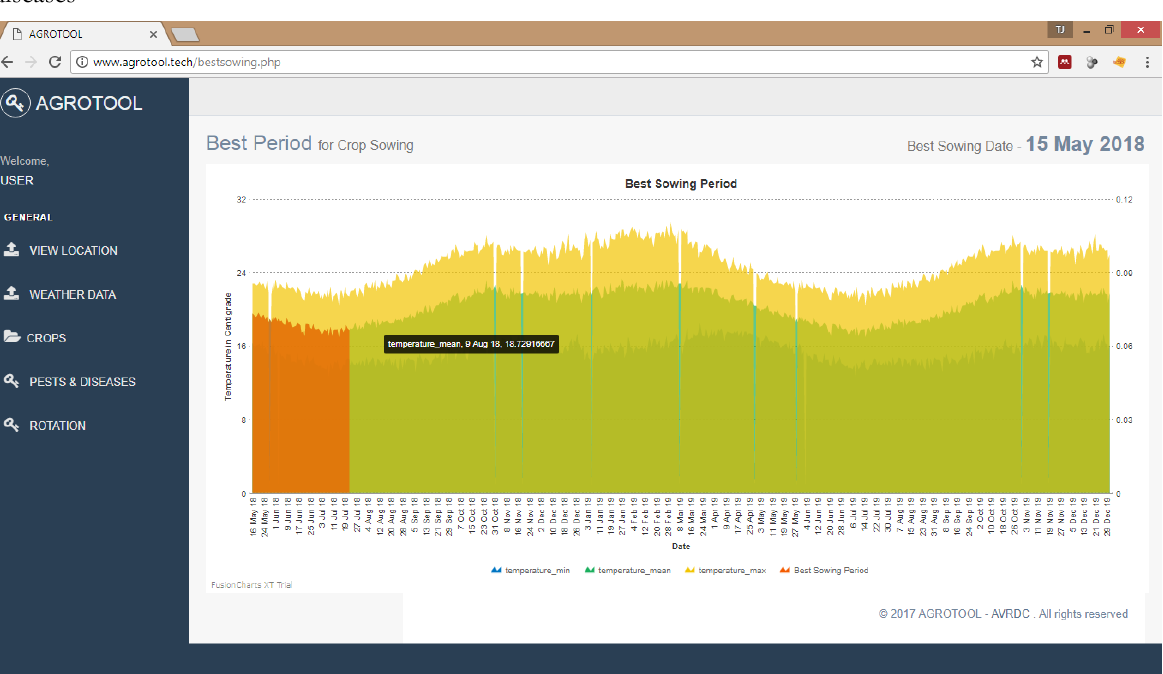
Figure 5. Graph for giving user a best sowing period suggestion based on the weather data in a particular selected